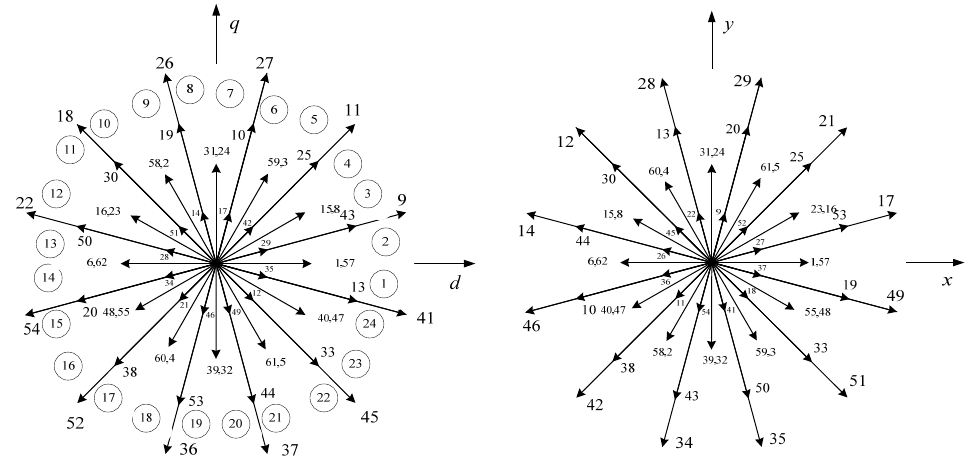
Figure 2. Space vectors in ( left ) d-q plane ( right ) x-y plane.